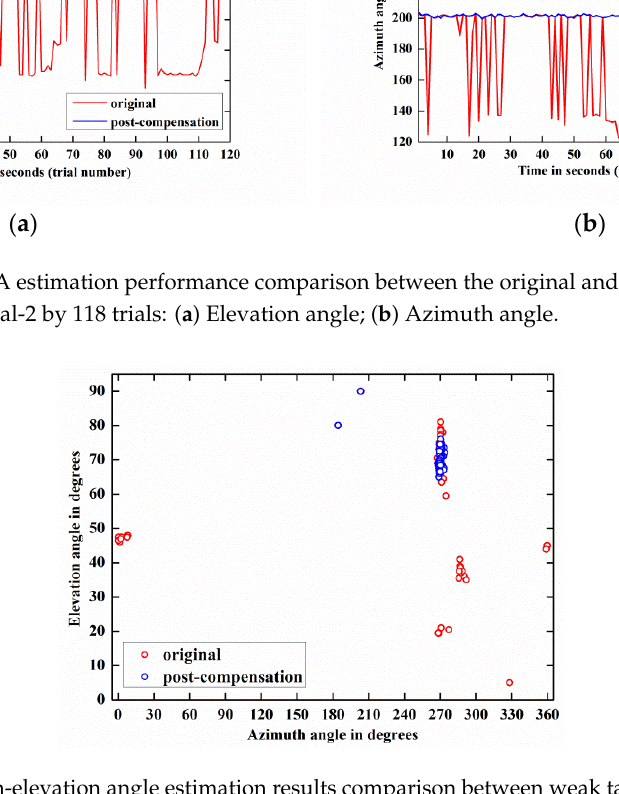
Figure 14. Azimuth-elevation angle estimation results comparison between weak target signal-1 before and after compensation.